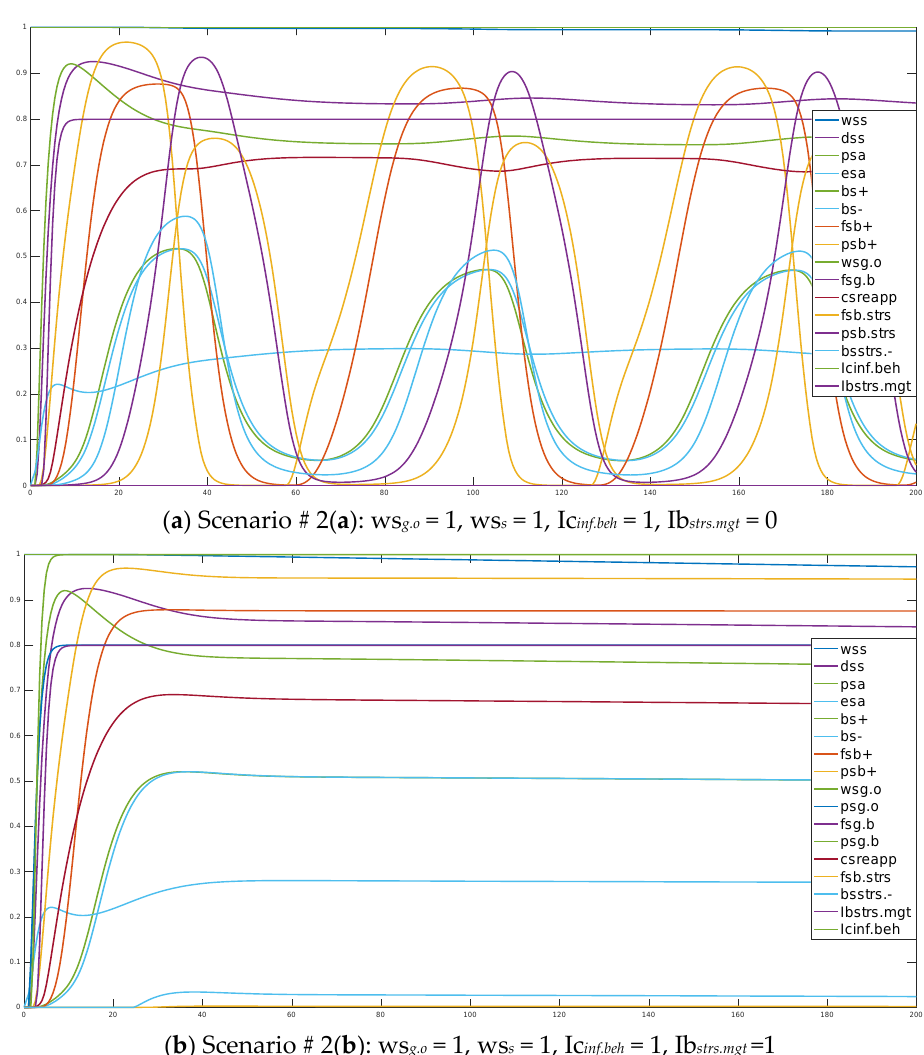
Figure 3. ( a ) Tempting food inducing the stress-eating cycle. ( b ) Breaking the tempting food-induced stress-eating cycle through a ‘stress management’ intervention.